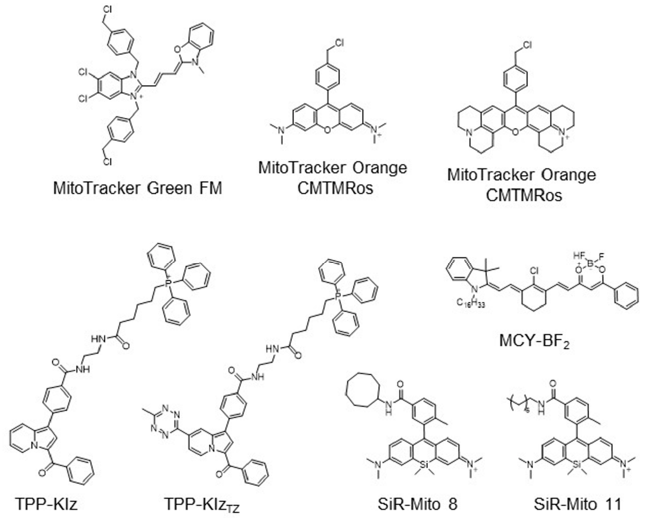
Figure 1. Chemical structures of various fluorescent chemical probes for mitochondrial biology Figure 1. [25,26,29–33].